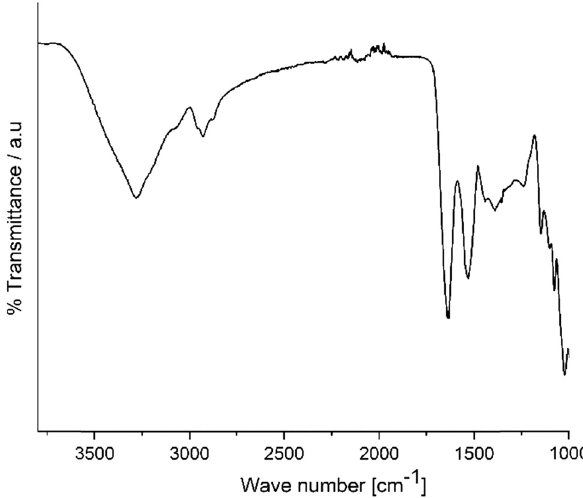
Figure A2: FTIR spectra of